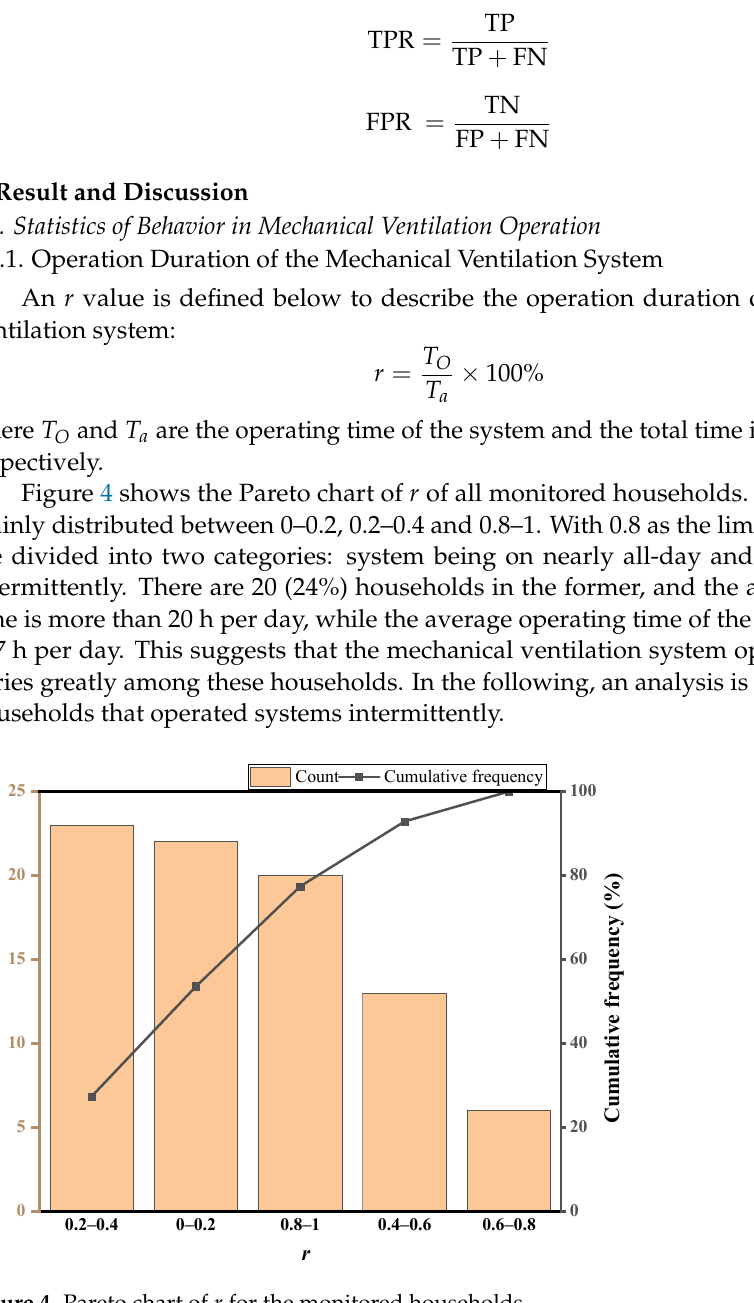
Figure 4. Pareto chart of 𝑟 for the monitored households